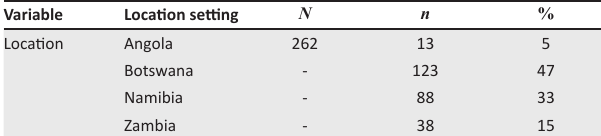
TABLE 1: Total sample size at each country setting.